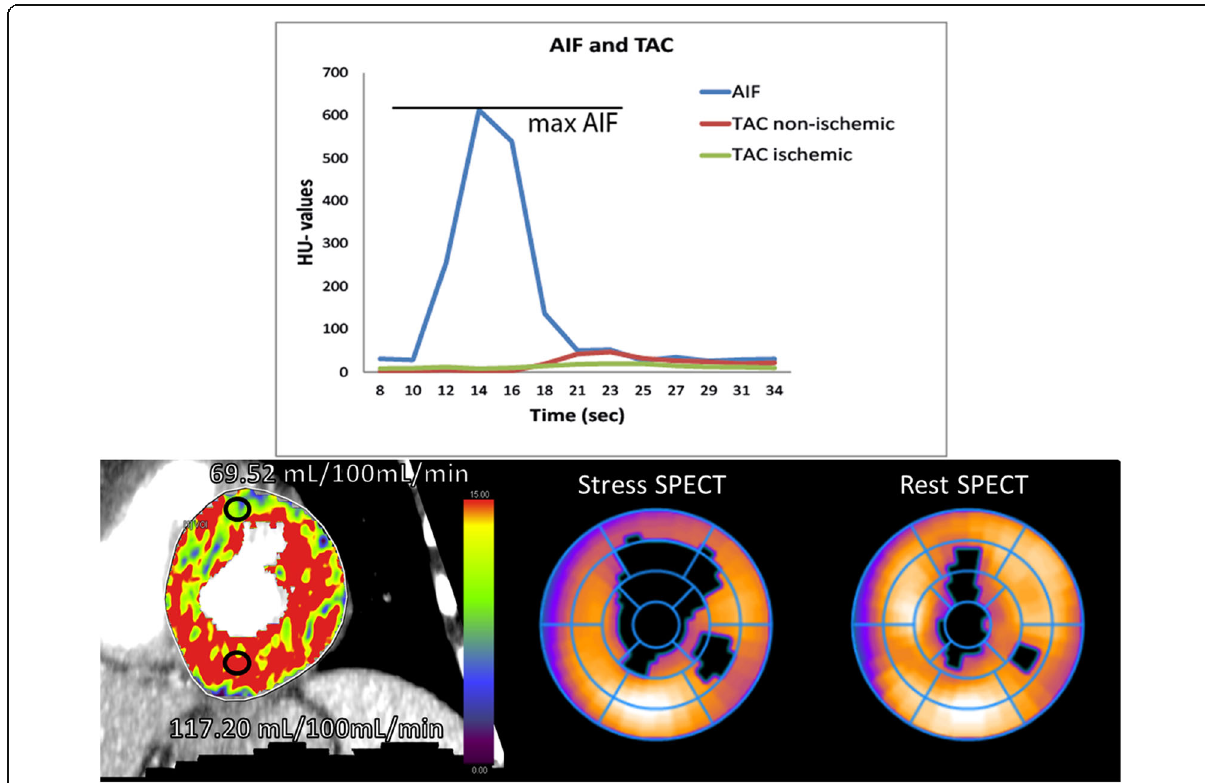
Fig. 6 The top image shows a schematic representation of the upslope method used to calculate myocardial blood flow. The lower images show a quantitative perfusion map, based on a deconvolution approach using a two-compartment model combined with the shown upslope method, resulting in quantitative MBF values. A perfusion defect, corresponding to the SPECT perfusion images, is visualised showing significantly lower myocardial blood flow values compared to normal